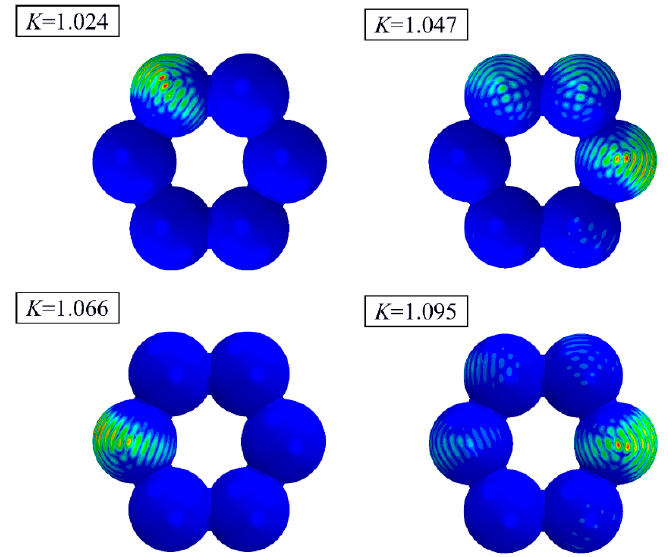
Figure 14. First-order eigenmode of sphere-segmented toroidal shells with ellipticity ( K ) of 1.024, 1.066, 1.083, and 1.095.